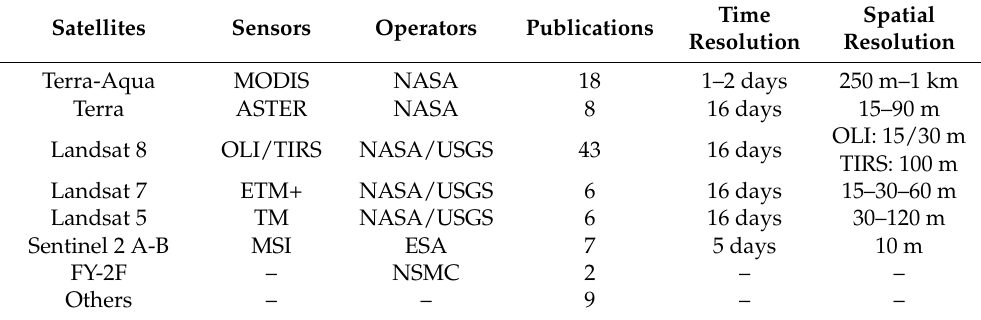
Table 3. Information about satellites and sensors used in the reviewed